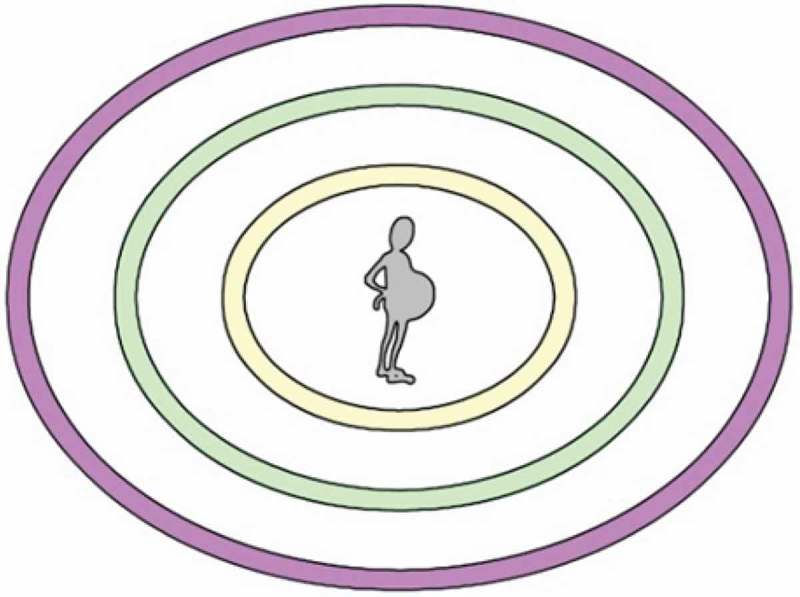
Blank CIRCLES map.